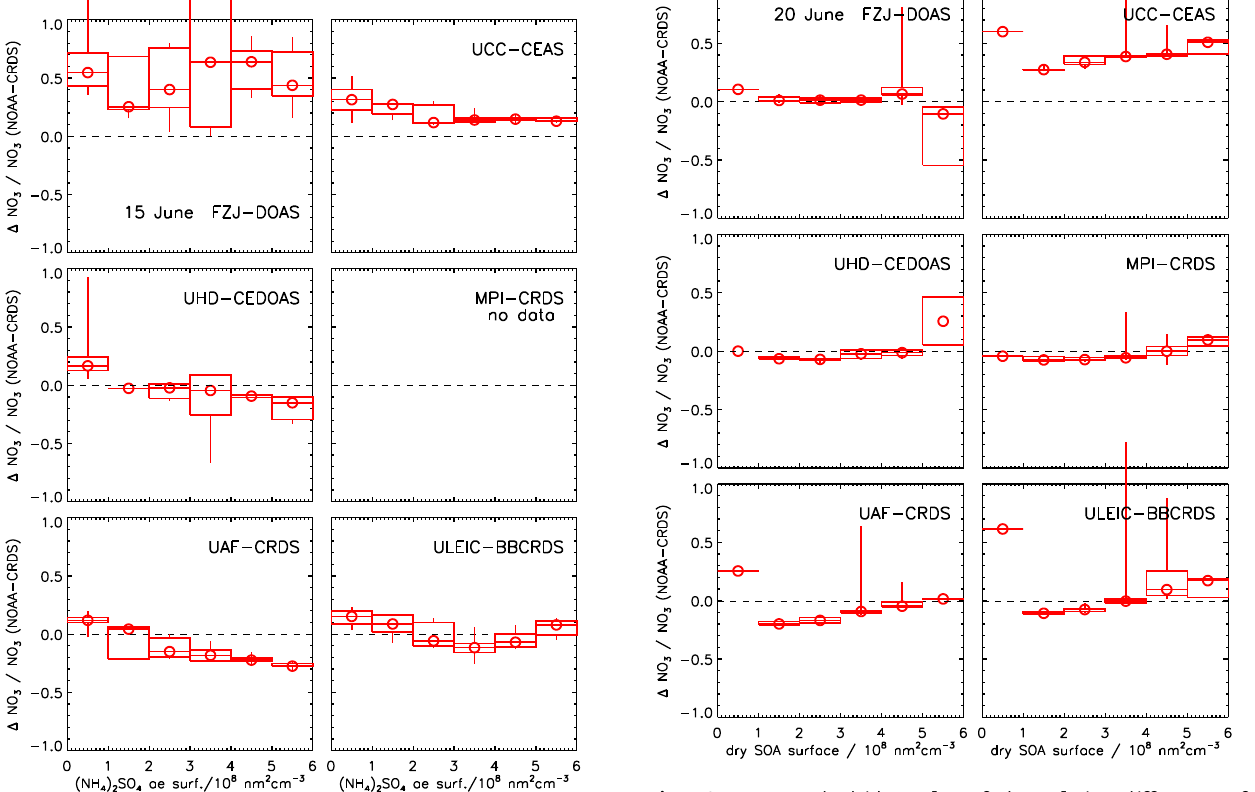
Fig. 12. Box-and-whisker plot of the relative difference of NO 3 measurements between various instruments and the refer- ence NOAA-CRDS as function of the surface of dry secondary or- ganic aerosol (SOA) during the “ β -pinene oxidation” experiment on 20 June. Dots are medians, boxes give the first and third quartile and whiskers denote the 10th and 90th